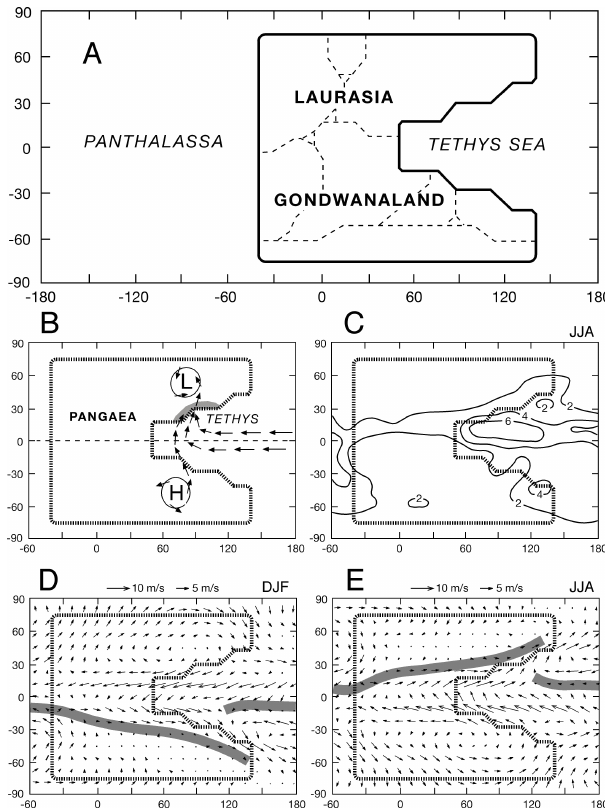
Figure 18. Mega-monsoon of Pangaea. (a) The idealized Pangaean continent. Fine dashed lines indicate the approximate outlines of modern landmasses. (b) Schematic diagram illustrating monsoonal circulation in northern summer. Arrows show surface winds, and stippling indicates heavy seasonal rains. (c) Modeled precipitation rate (mmd − 1 ) on Pangaea for summer. (d) , (e) Modeled surface winds on Pangaea for winter (d) and summer (e) ; note the seasonal reversal of the wind direction. The gray bar shows the poleward limit of summer monsoon over land and the intertropical conver- gence zone over the ocean (Wang and Li, 2009; modified from Kutzbach and Gallimore,